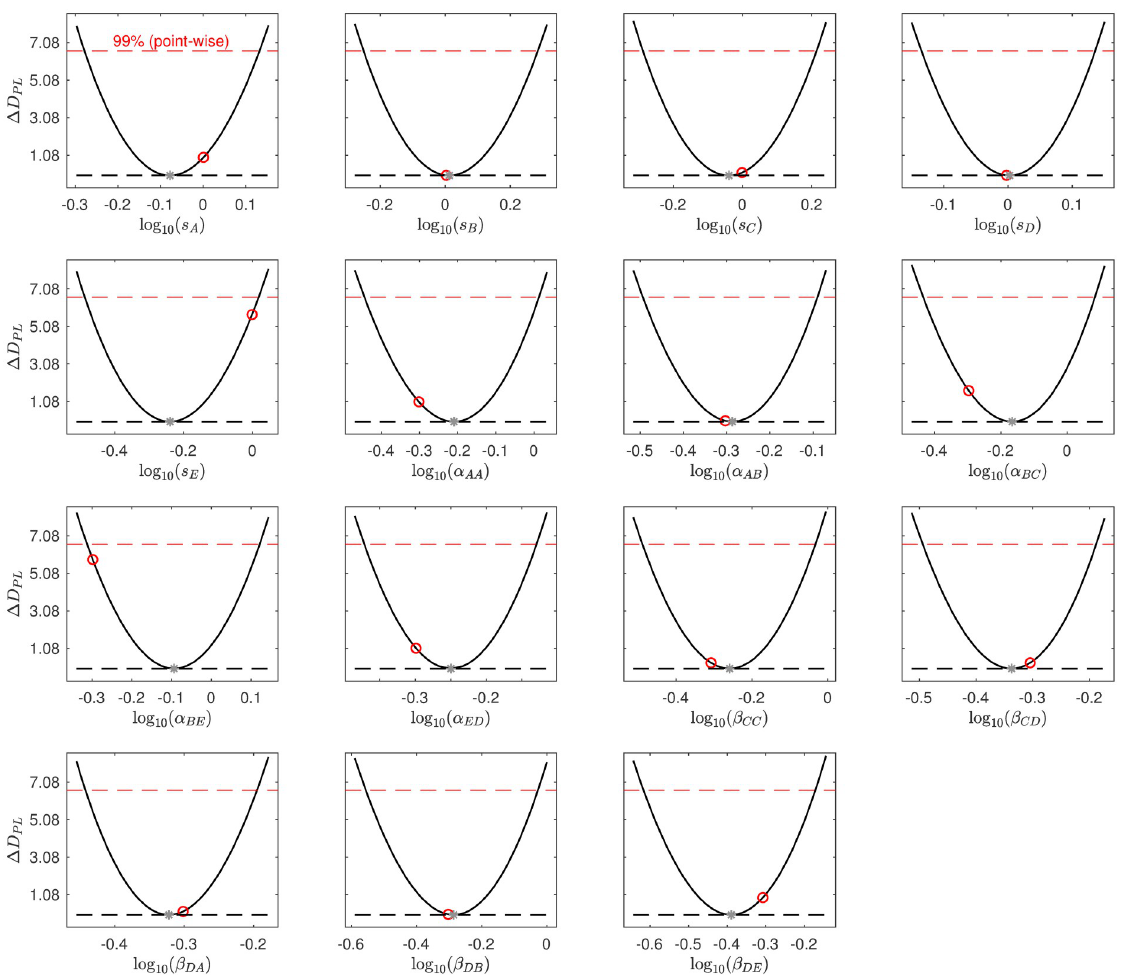
Fig 8. Profile likelihood plots for the ten edge parameters of the selected 10-edge 5 cytokine test model. The parameter θ over a broad range of values and for each fixed value of θ m , the increase in D likelihood function as defined in Eq (3), and ~ θ line. The parameter values used to generate the synthetic dataset are shown as red dots. The parameter values resulting in the minimal D ¼ (cid:0) 2 log ð L ð θ ÞÞ are shown as grey stars. This figure has been generated using the Matlab environment ‘Data2Dynamics’ [32, 33]. min θ